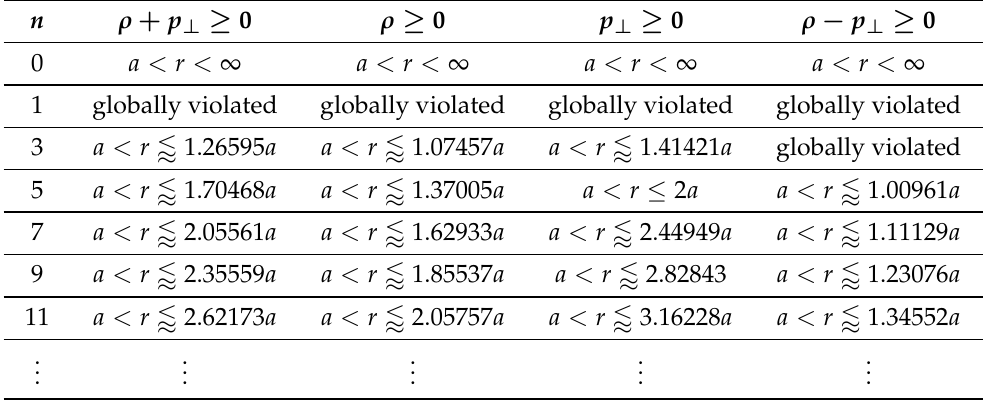
Table 1. Regions of the spacetime where the orthonormal components of the stress-energy tensor satisfy certain inequalities.